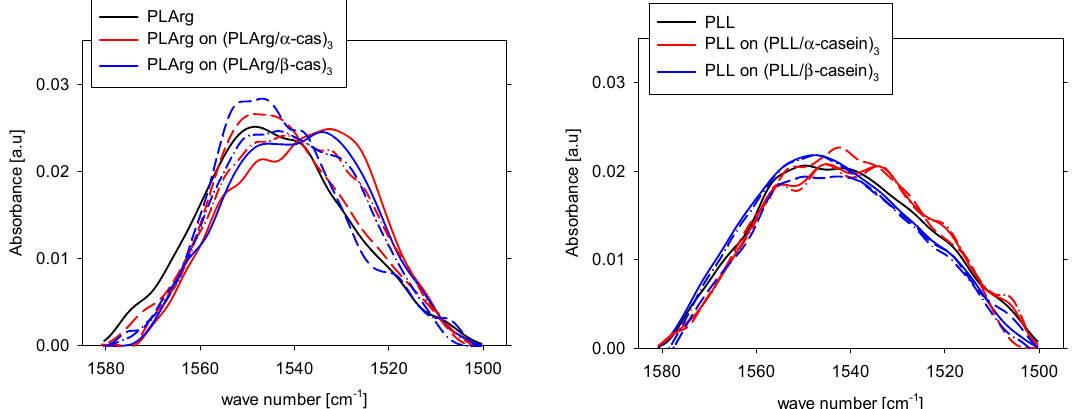
Figure 12. Amid II vibration band for polypeptide film (black) and for polypeptide layer on top of the multilayer film with caseins for poly-L-arginine and poly-L-lysine. Meaning of curves as in Figure 10.